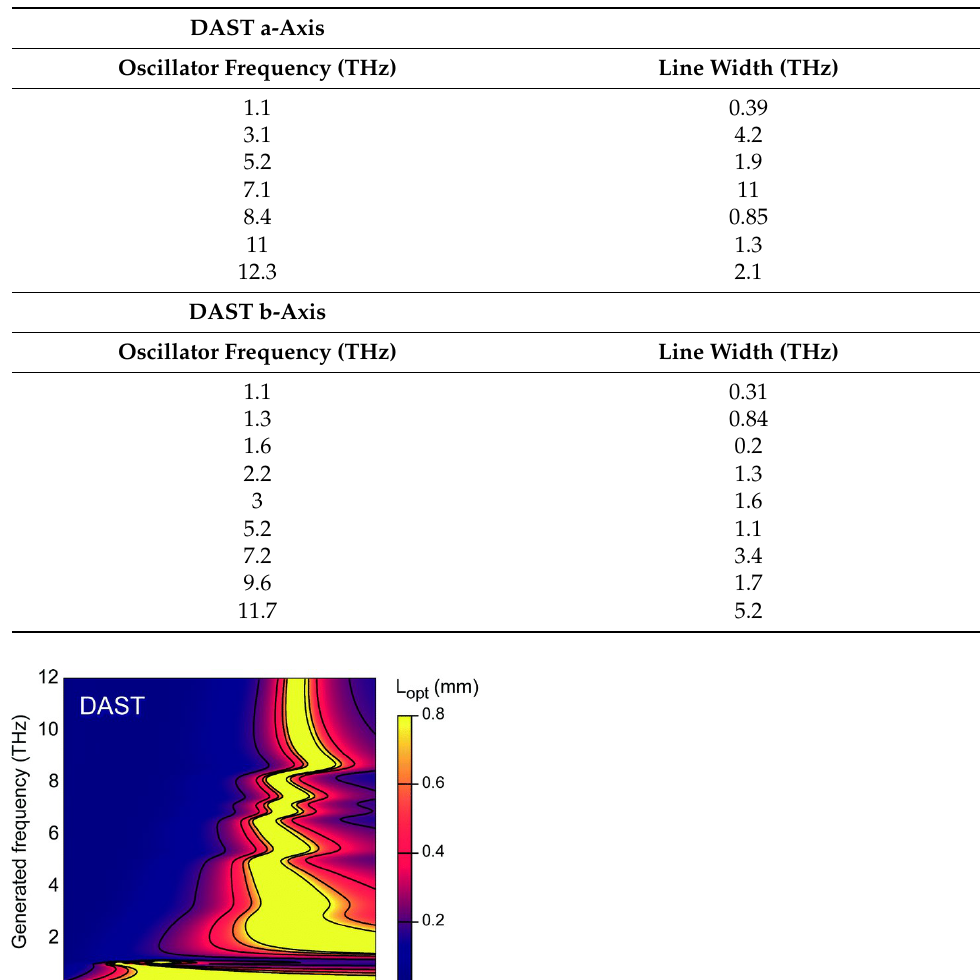
Table 10. Phonon resonances of DAST [94].